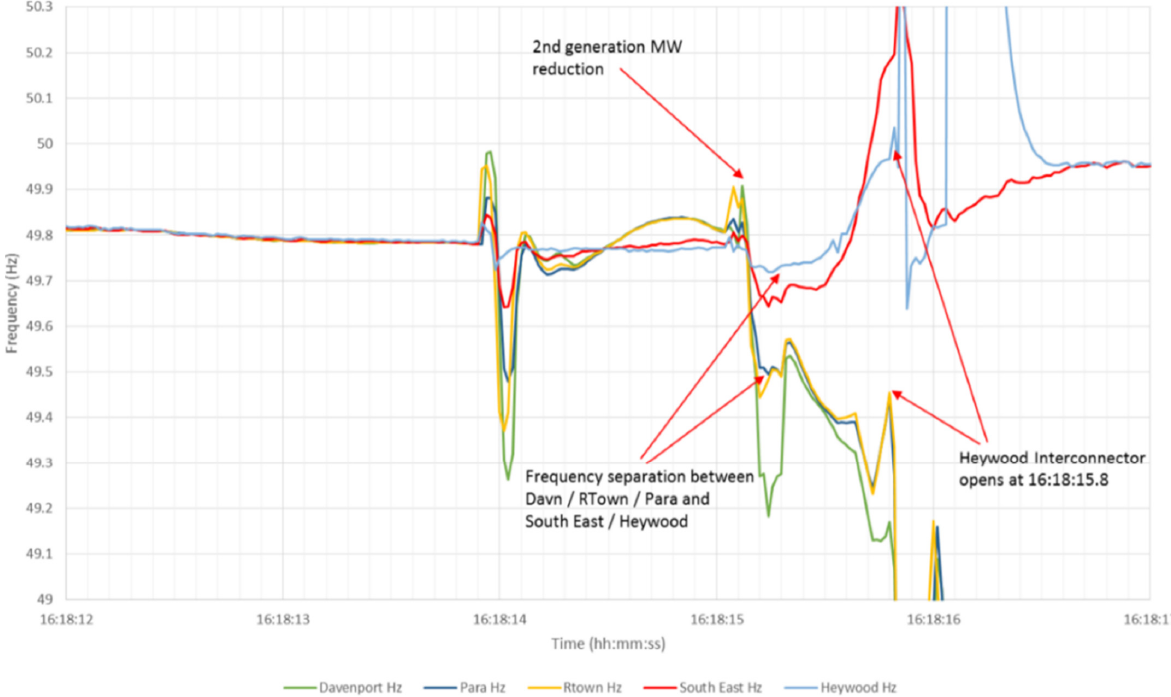
Figure 9. Dynamics of frequency in various nodes of South Australian grid during the failure on 28 September 2016 [73]. Furthermore, similar events were also recorded on 1 November 2015 (110,000 house- holds affected), 1 December 2016 (200,000 households affected and restored after 1 h), 27 December 2016 (125,000 households affected and restored after 4 days), 20 January 2017 (58,000 households affected), 8 February 2017 (90,000 households affected), and 25 August 2018 in the Australian power system. These events highlighted the vulnerability and sen- sitivity of the Australian power system. The major issues behind these frequent failures are considered to be the high penetration of PEC-based technologies and the unpredicta- ble nature of RESs, as well as the damage of transmission lines from natural disasters [74]. 3.2.5. Power System Blackouts in California, USA California is the state that has faced the greatest number of system failures in the history of the USA. From 2008 to 2017, 4297 power outages were recorded just in Califor- nia [100]. It is quite challenging to cover all failures; thus, this subsection only discusses the blackout that occurred in California last year. On 14 August 2020, a giant rolling black- out was implemented in California because of the high electrical demand. Because of a huge wildfire, the maximum temperature of California reached up to 130 °C. Because of the COVID-19 pandemic, most people were also staying at their homes and using their electrical appliances. Furthermore, the extreme heatwave forced people to operate their air-conditioning units, which significantly increased the total system demand. According to the data from the California Energy Commission, a large proportion of electricity is generated from RESs, with plans to increase the proportion to 60% by 2030. In 2019, 21.04% of electricity in California was generated by solar and wind energy resources [101]. On 14 August, a 470 MW solar power plant and several wind power plants (1000 MW total production) failed because of the excessive demand [102]. At the same time, so-called reliable power generators unexpectedly went offline [103]. The rolling blackout was im- plemented at around 6:30 p.m., when the power generation from solar power plants was disappearing, and continued until 9:00 p.m. [104]. According to various statements, it